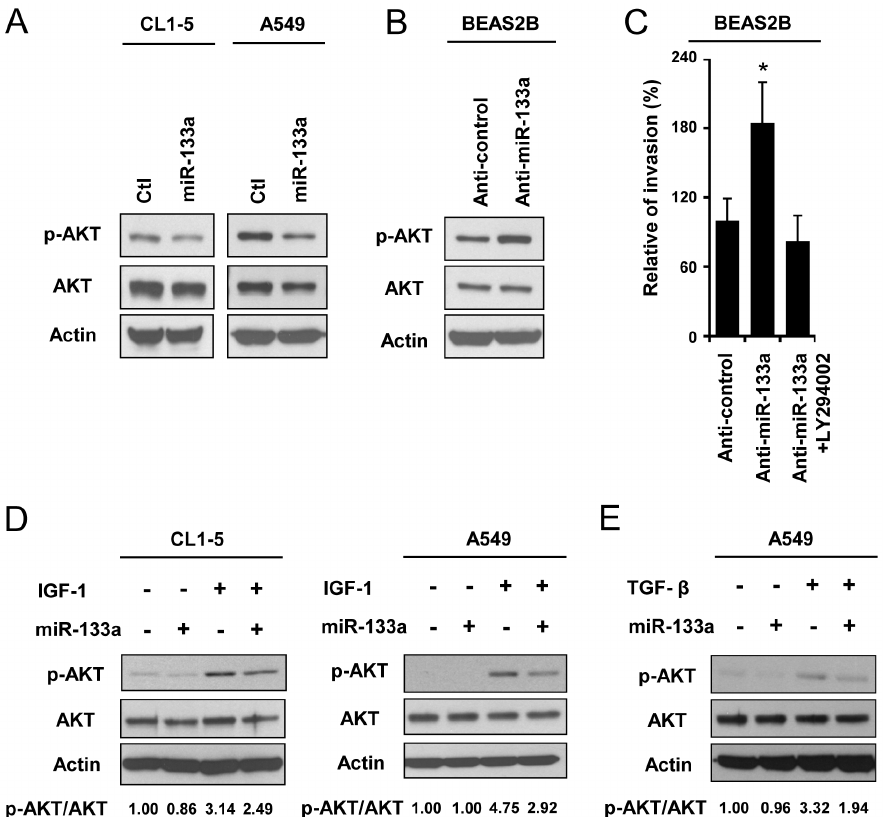
Figure 4. MiR-133a modulates AKT activation and suppresses IGF-1- and TGF- b -mediated AKT signaling in lung cancer cell lines. (A) 72 hours after infection with the AS2-neo (Ctl) or AS2-Neo-miR-133a viruses, the protein levels of pAKT (Ser473), AKT and b -actin were examined in CL1-5 and A549 cells. (B) 72 hours after transfection with the anti-miR-133a inhibitor, the protein levels of pAKT (Ser473), AKT and b -actin were examined in BEAS-2B cells. (C) Measurement of the cell invasion ability of BEAS-2B cells after anti-miR-133a inhibitor (100 nM) and LY294002 (50 m M) pre-treated for 48 hours. The number of invasive cells was counted 24 hours after seeding cells in a transwell containing matrigel. (D,E) AKT phosphorylation levels of stable miR-133a-expressing CL1-5 and A549 cells or control CL1-5 and A549 cells were examined after treatment with 250 ng/ml IGF-1 for 30 min (CL1-5 cells) or 2.5 min (A549 cells) (D) or treatment with 0.2 ng/ml TGF- b for 5 min (A549 cells) (E). The quantification of the immunoblot data are expressed as a pAKT (Ser473)/AKT ratio after normalization to b